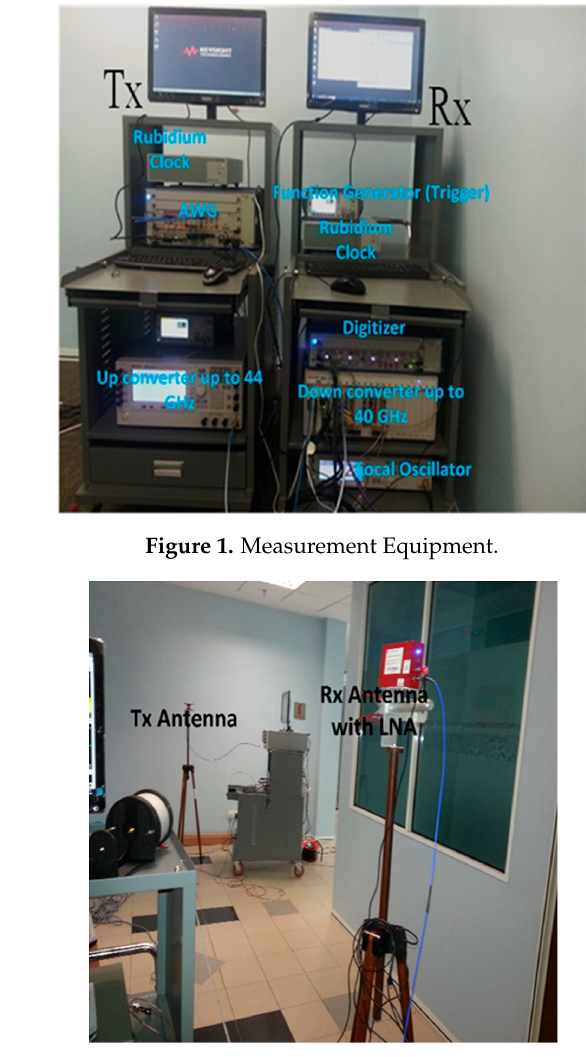
Figure 2. Measurement Environment.